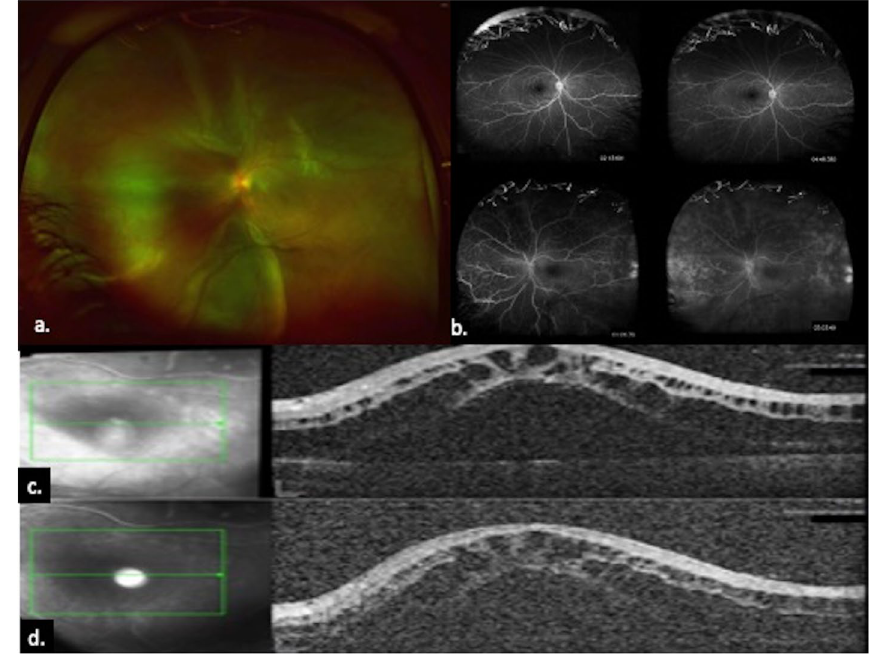
Fig. 1 a LE Fundus picture shows total exudative retinal detachment, b Fluoresceine Angiography shows profuse vascular leakage in the LE, c OCT at presentation shows macular detachment with intra- and subretinal fluid, d OCT shows lack of improvement after the institution of intravenous steroids, methotrexate and intravitreal